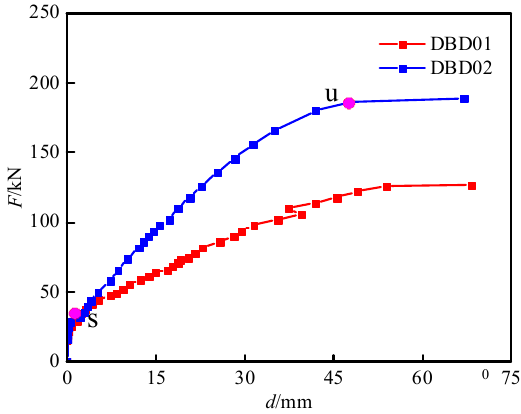
Figure 14. Load-mid span deflection